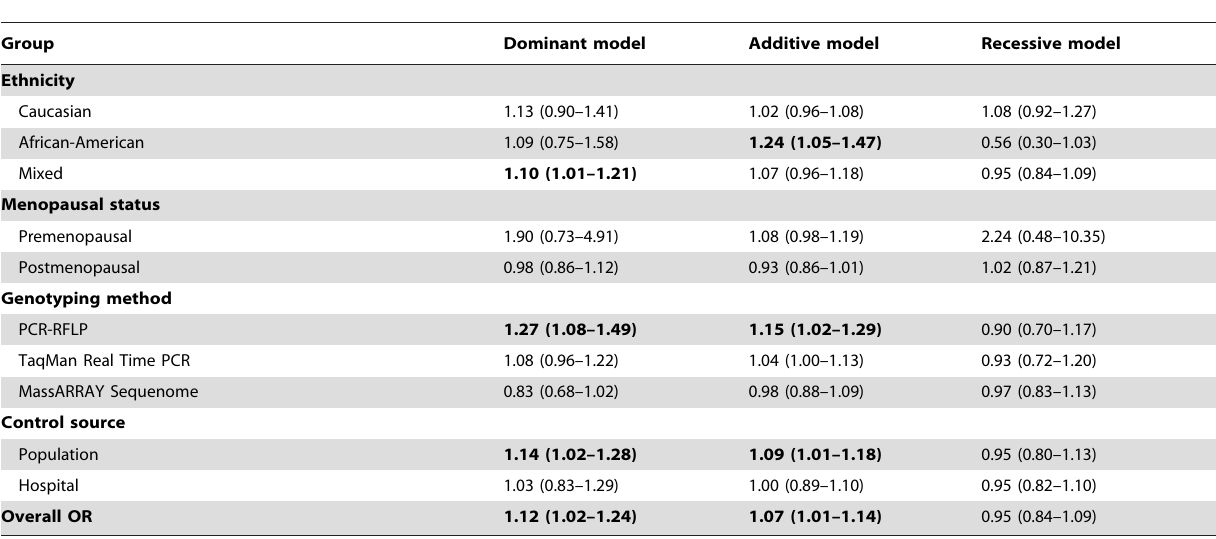
Table 2. Results of overall analysis and subgroup analysis in this meta-analysis.